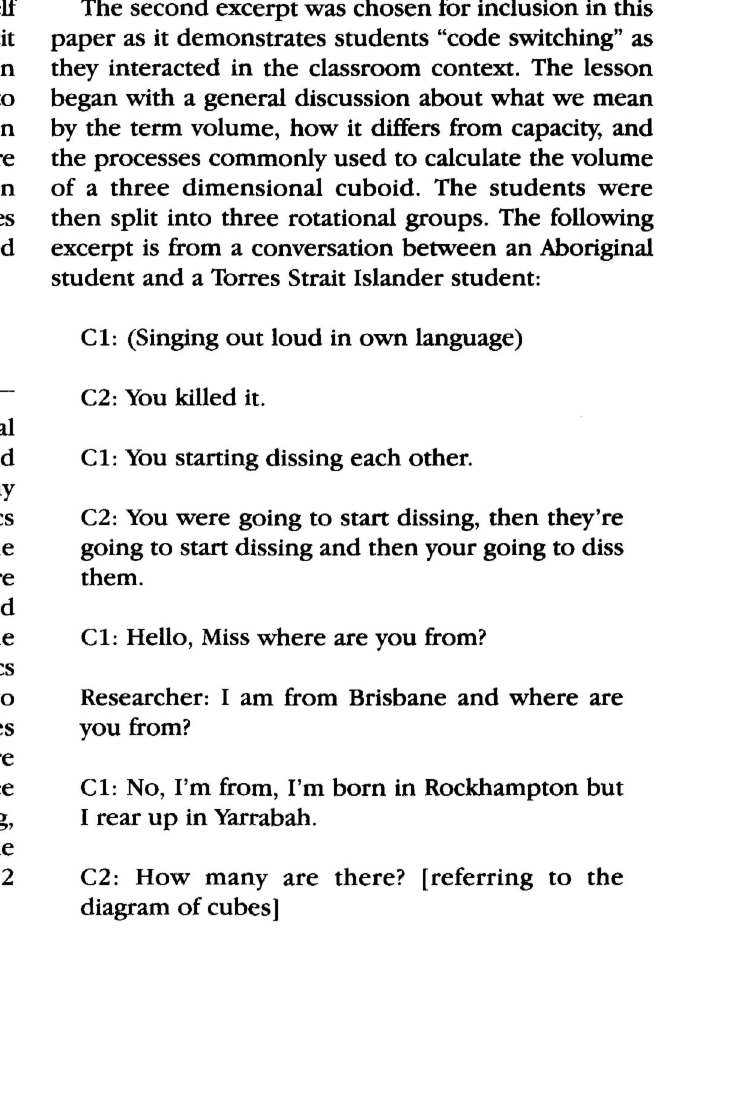
Figure 2. Examples of tasks presented to the students. They were asked to work in pairs to construct the shapes using blocks and record the number of blocks each shape consisted of, that is, record the volume of the shapes. Most students struggled with this task, especially interpreting the diagram as a three dimensional shape and then using the cubes to reconstruct a real world model of the shape. Classroom observation indicated that they appeared to be able to "see" the flat face of the shape (for Figure 2 (a) it has 9 blocks) but experienced difficulty in recognising its depth (3 blocks) It is conjectured that this was not due to a lack of spatial ability but rather experiential resulting from having limited experience with playing with blocks and interpreting diagrams such as "lego plans", a common early childhood activity in many white students' home